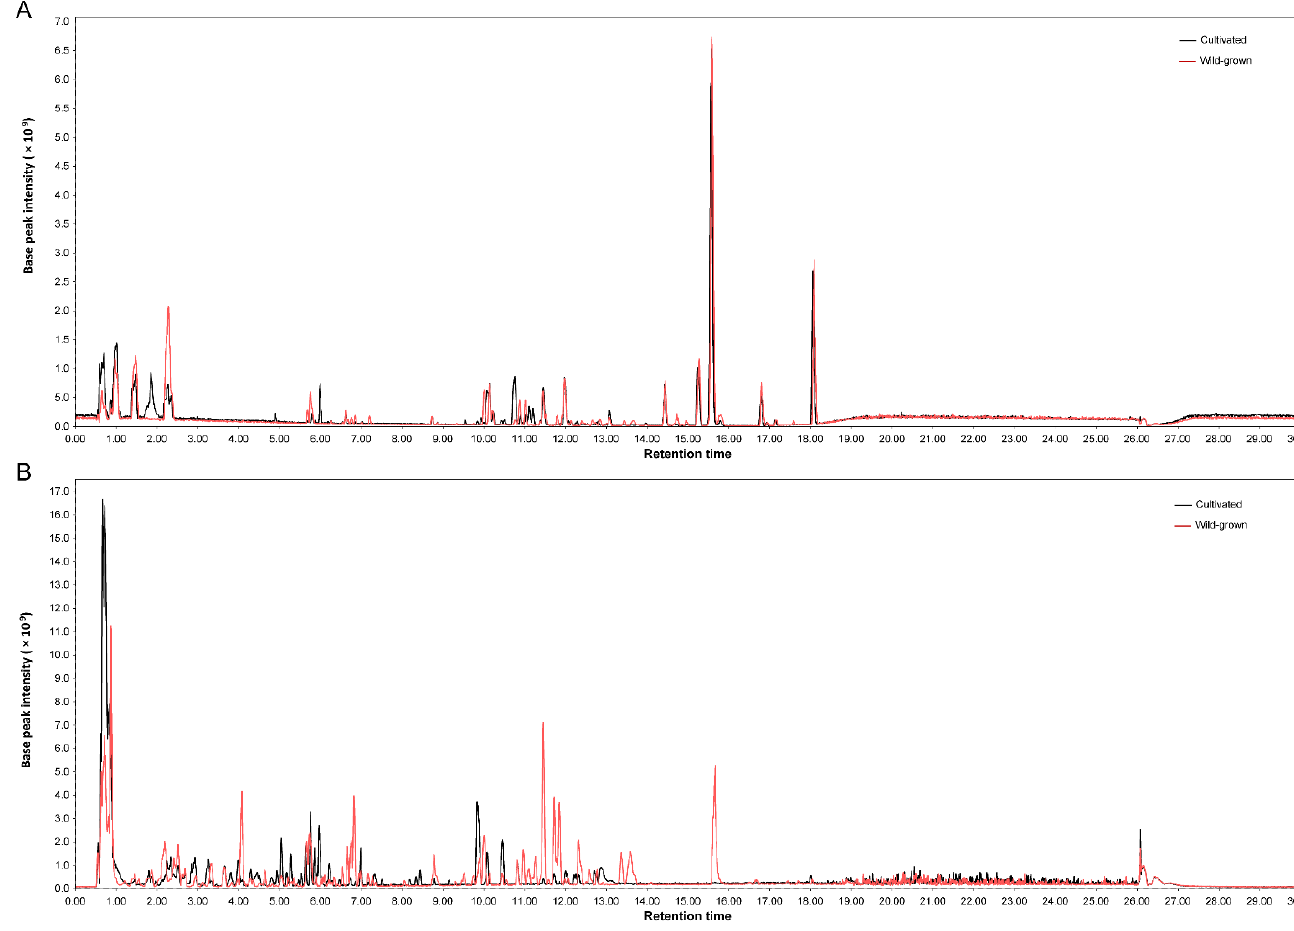
Figure 1. The representative base peak chromatograms of the cultivated and wild-grown P. sibiricum acquired in positive ( A ) and negative ( B ) ionization modes.